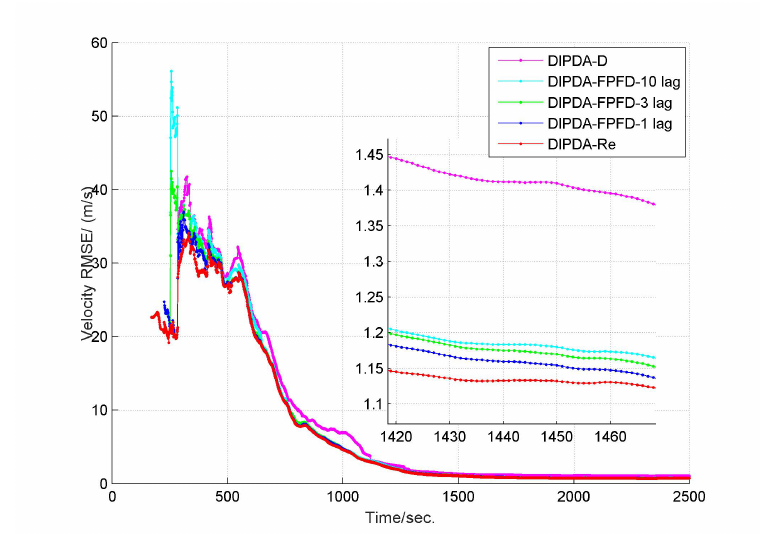
Figure 15. RMSE of estimated target velocity of DIPDA-D, DIPDA-Re, DIPDA-FPFD with different lags (case 3).